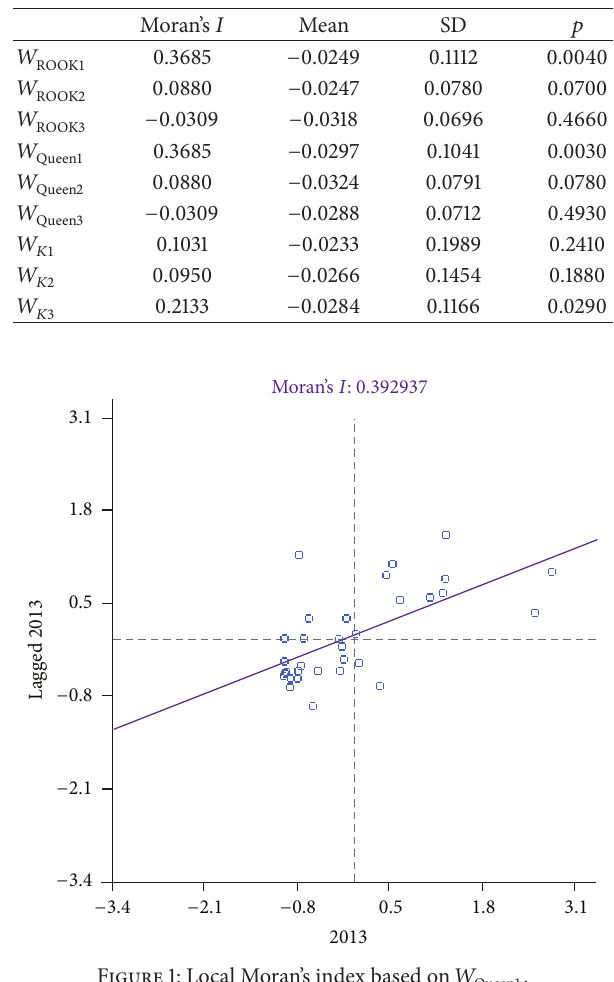
Figure 1: Local Moran’s index based on 𝑊 Queen 1